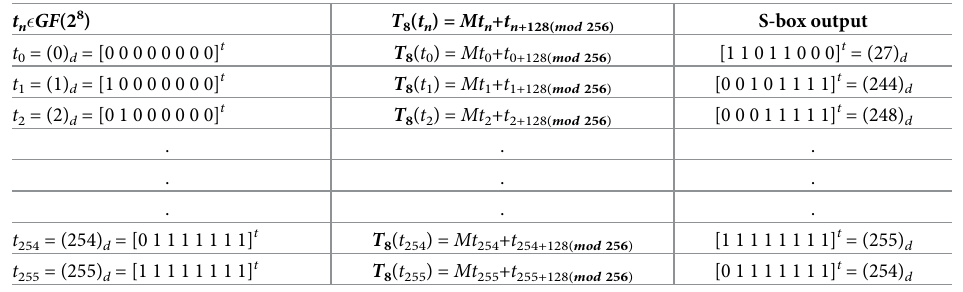
Table 1. Generation of the proposed S-box elements based on a transformation T 8